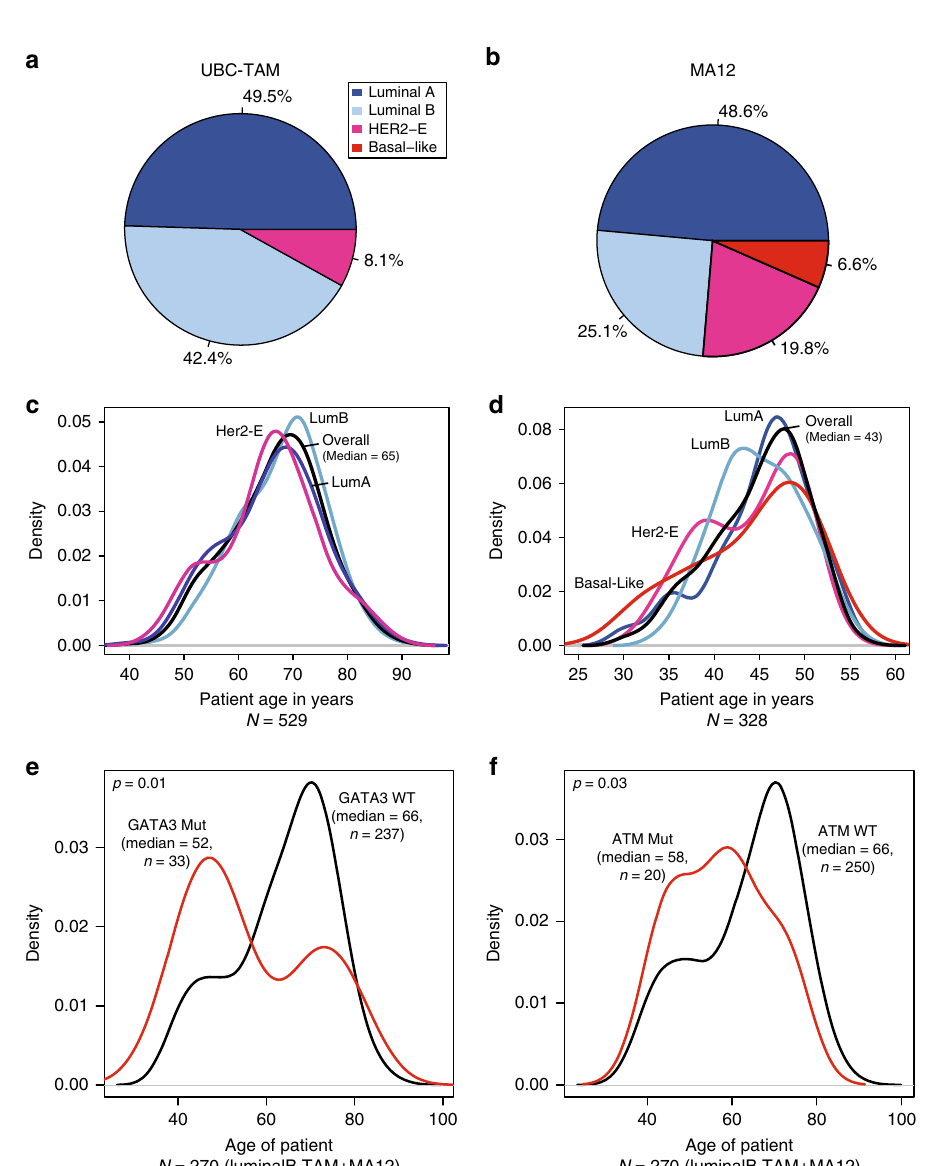
Fig. 2 Cross-cohort age and subtype analysis. a , b Percentage composition of samples by intrinsic subtype of the tumor in the two discovery cohorts for UBC-TAM ( a ) and MA12 ( b ) cohorts. c , d Age-density plots for patients categorized by intrinsic subtype in UBC-TAM ( c ) and MA12 ( d ) cohorts. The overall median age shows that UBC-TAM is constituted mostly of postmenopausal patients (median age = 65), in contrast to MA12, which has younger patients (median age = 43). e , f Younger luminal B subtype patients harbor GATA3 ( e ) and ATM ( f ) mutations in the combined set of UBC-TAM and MA12 Luminal B cases (median age = 52, p = 0.01; median age = 58, p = 0.03 for GATA3 and ATM, respectively). Signi fi cant p values were determined